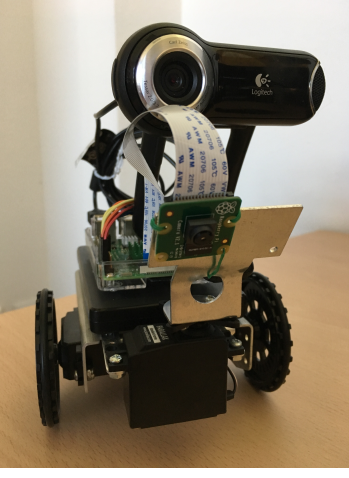
Figure 14. PiBot equipped with both cameras: PiCamera and Logitech. Table 3. Logitech QuickCam Pro 9000 technical